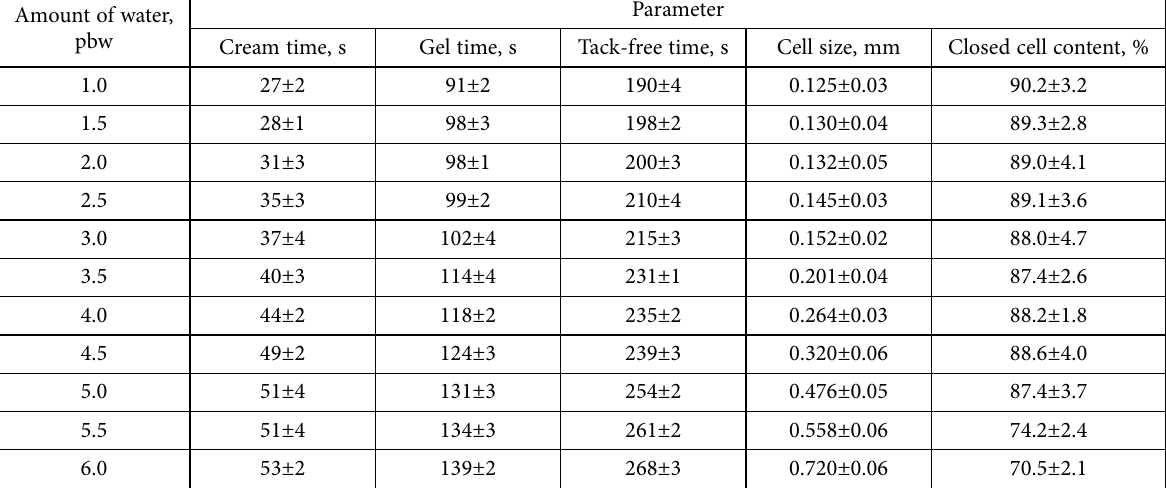
Table 4. Characteristic foaming times and structural parameters of polyurethane foams Amount of water,